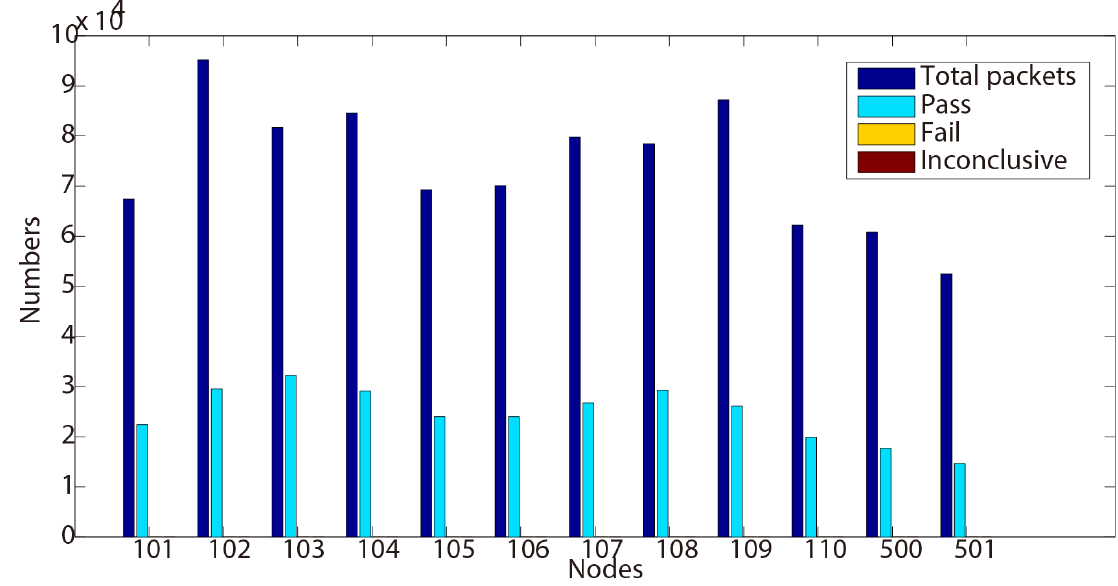
Figure 2. Test results for Property 2 (Day